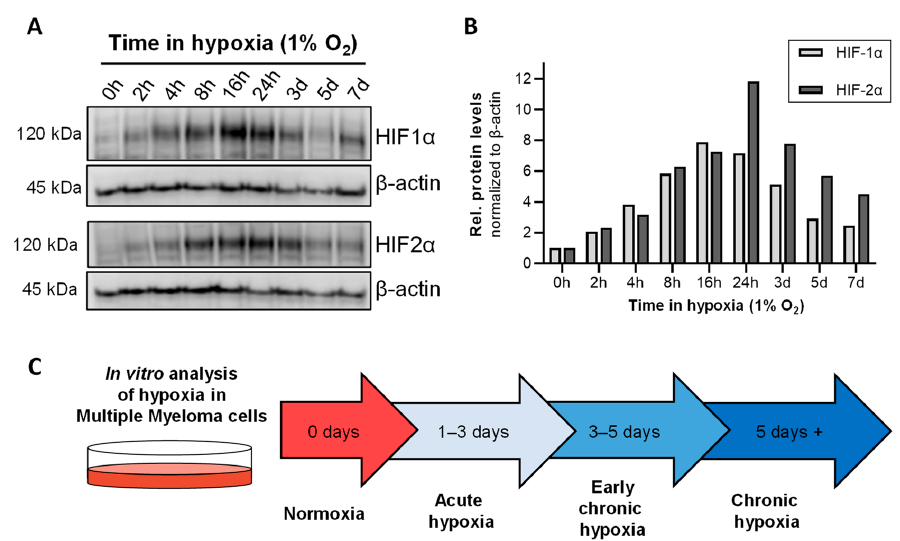
Figure 2. HIF1 α and HIF2 α levels during the adaptation to hypoxia: ( A ) Western blot of HIF1 α (upper blot) and HIF2 α (lower blot) levels during the adaptation to hypoxic conditions (1% O 2 ) up to 7 days in RPMI-8226 cells. Loading control: β -actin. ( B ) Densitometric quantifications of protein levels (HIF1 α and HIF2 α ). Signals were normalized to β -actin. ( C ) Model of adaptation of MM cells to hypoxia in in vitro cell culture. Abbreviations: h = hours; d = day; rel. = relative; kDa = kilodalton.